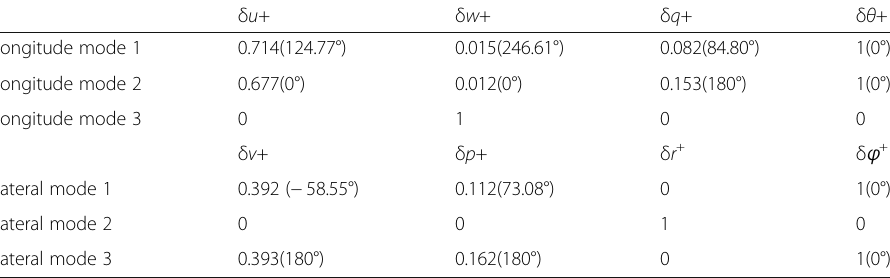
Table 9 Eigenvectors of the system matrix